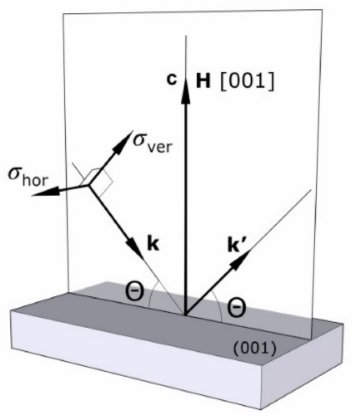
Figure 2. Illustration of the directions of polarization vectors relative to the crystal axes in an experiment to measure X-ray linear dichroism in a crystal CeCoGe 3